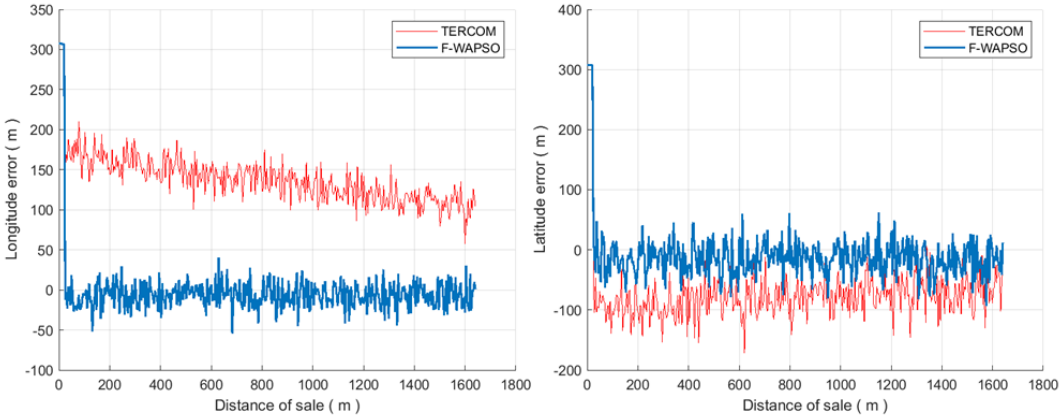
Figure 9. Longitude and latitude error curves of trajectory C.